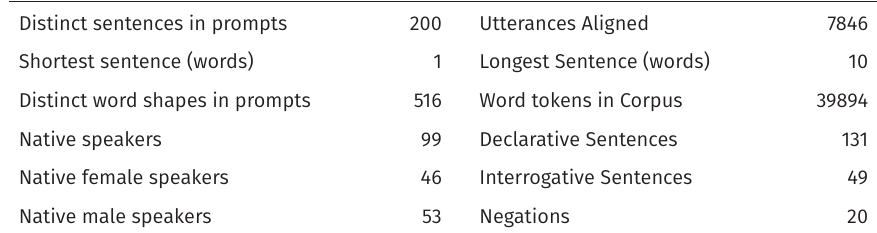
Table 1: General Information on the West Point Corpus.